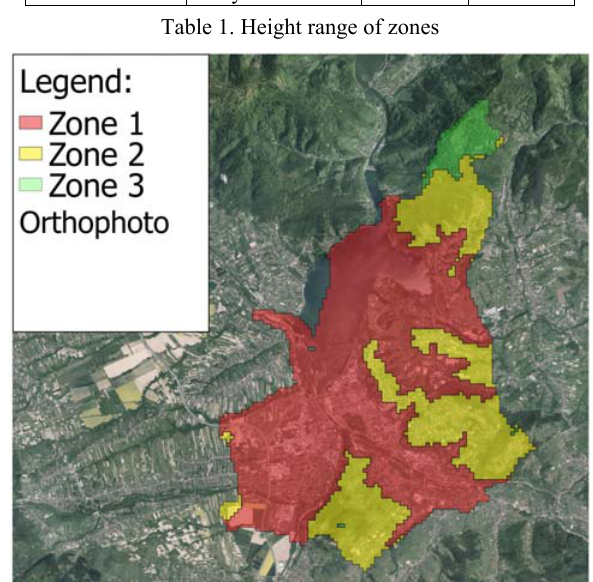
Figure 2. Zones derived from DTM